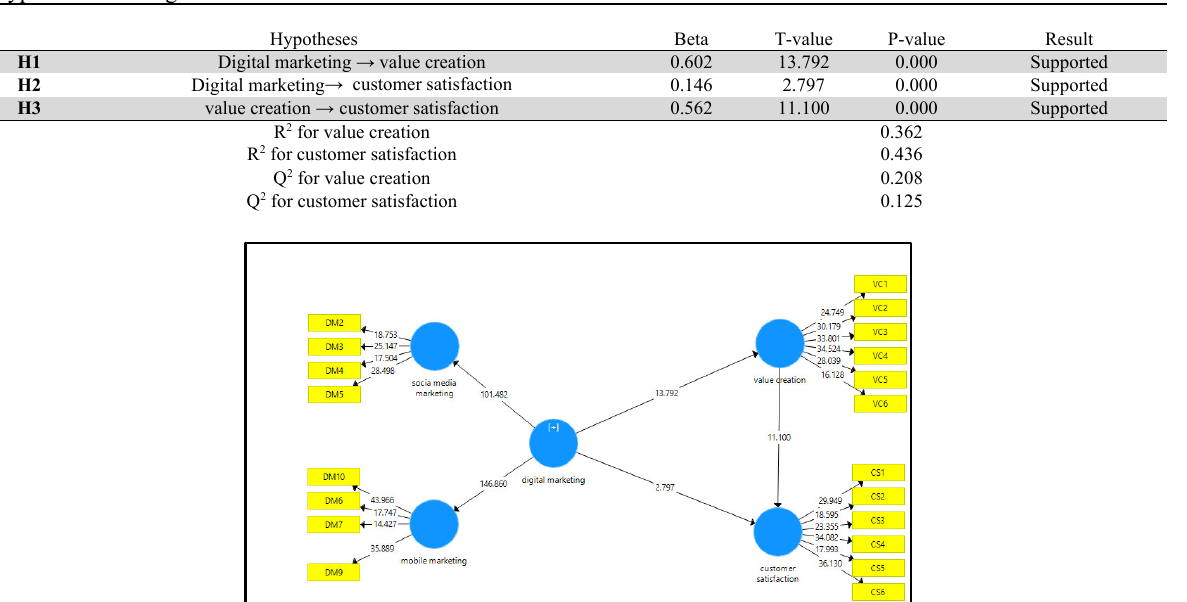
Hypotheses Testing